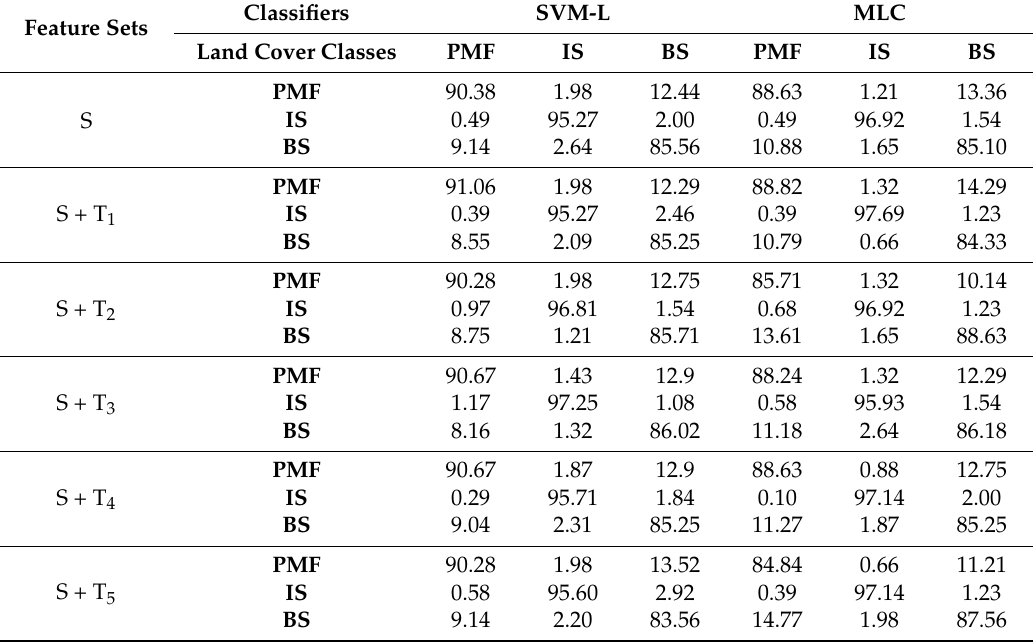
Table 2. Confusion matrix of parts land cover classes (PMF, IS and BS) from SVM-L and MLC. Feature